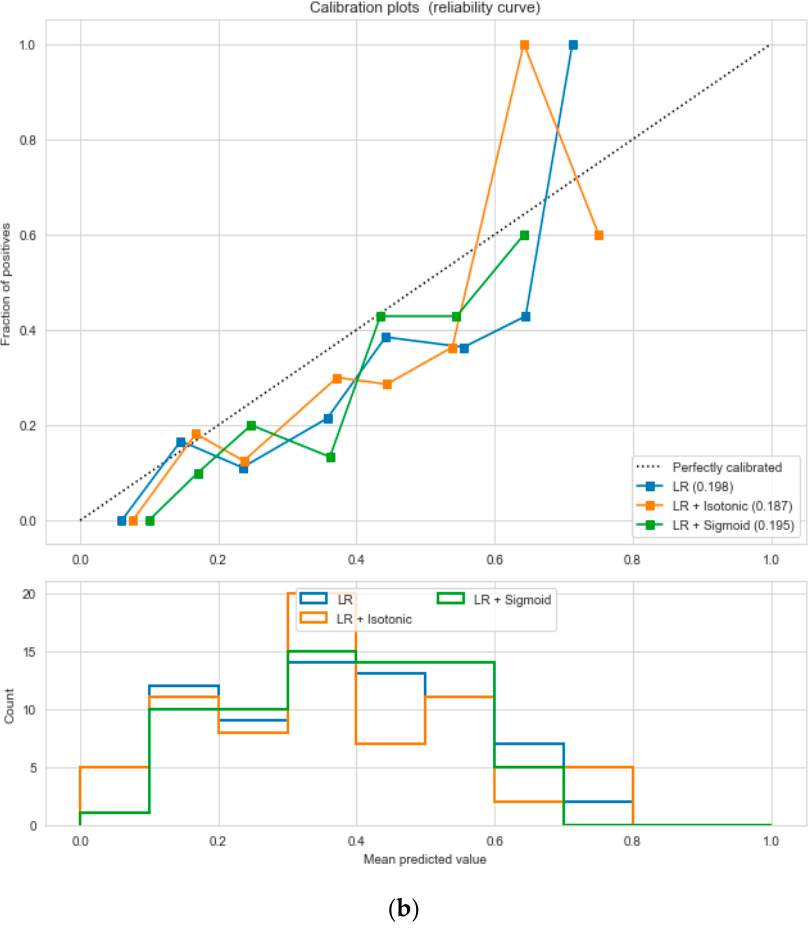
Figure 19. ( a ) Reliability curve to classify the “Cardiovascular disease” data with different ML classifiers. ( b ) Reliability curve to classify the “Cardiovascular disease” data with the “Calibrated LR”.